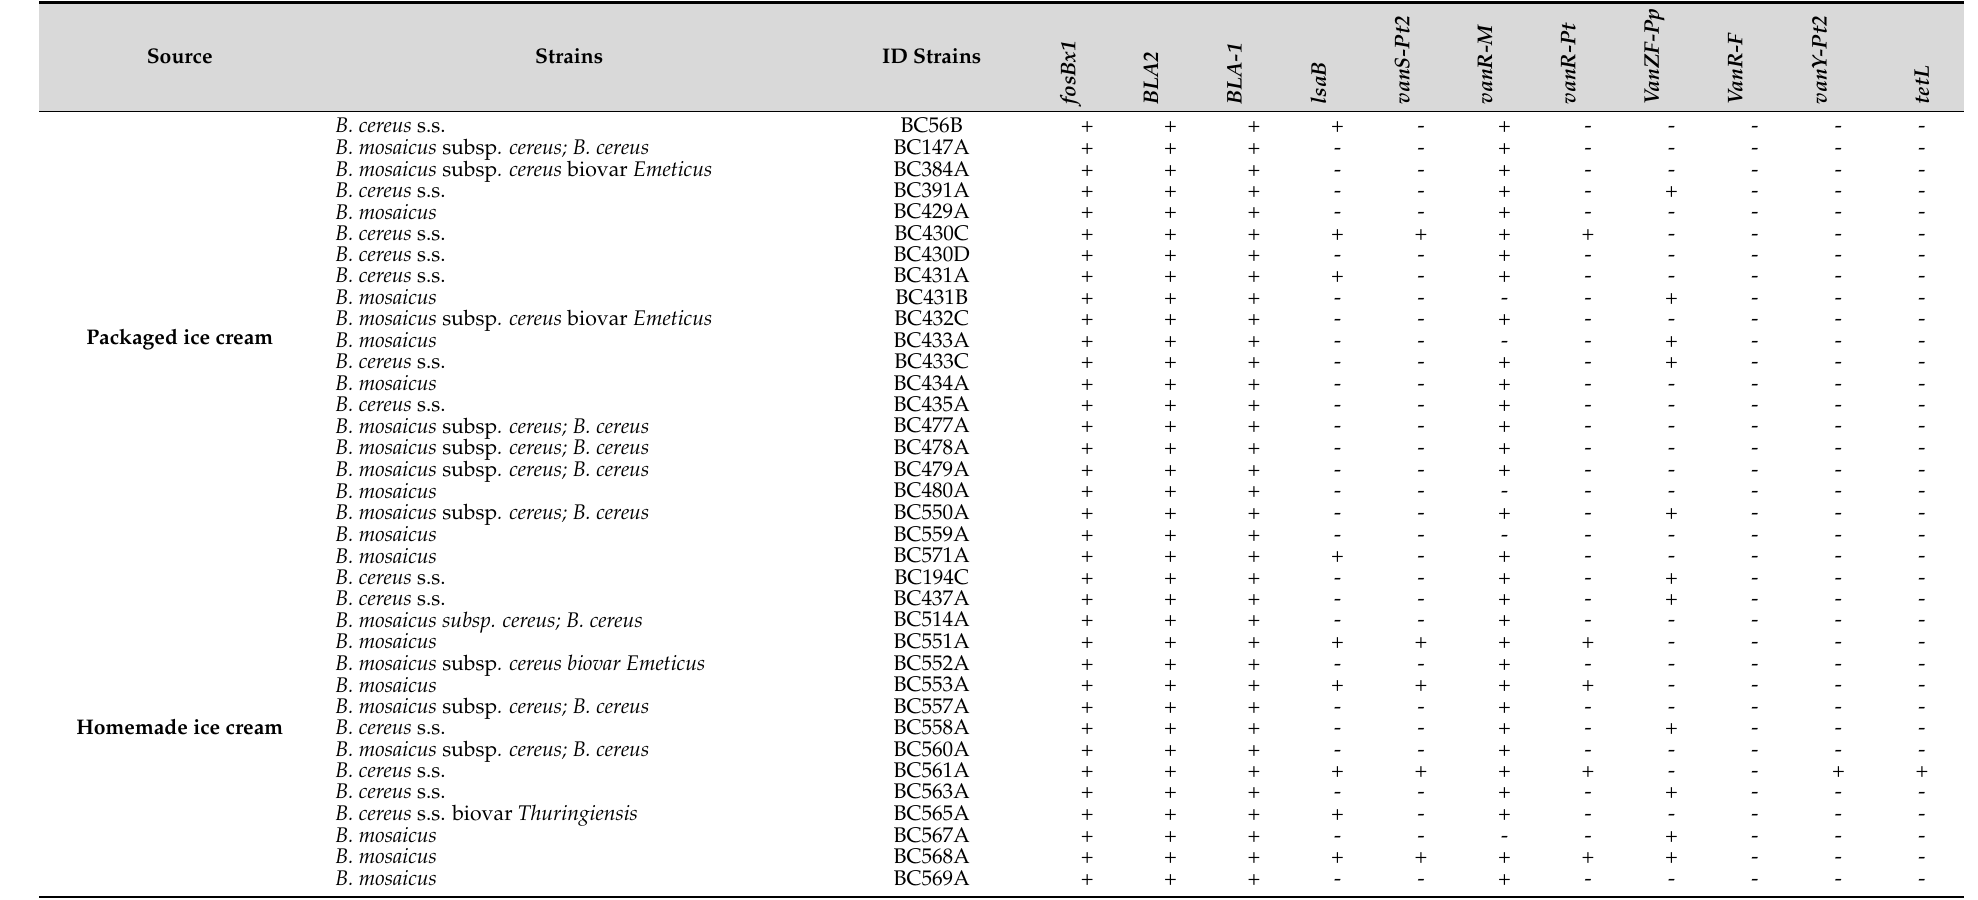
Table 2. Occurrence of antimicrobial resistance genes identified in the strains of B. cereus s.l. In the table are the AMR genes predicted by the BTyper tool. (+): presence; (-): absence.